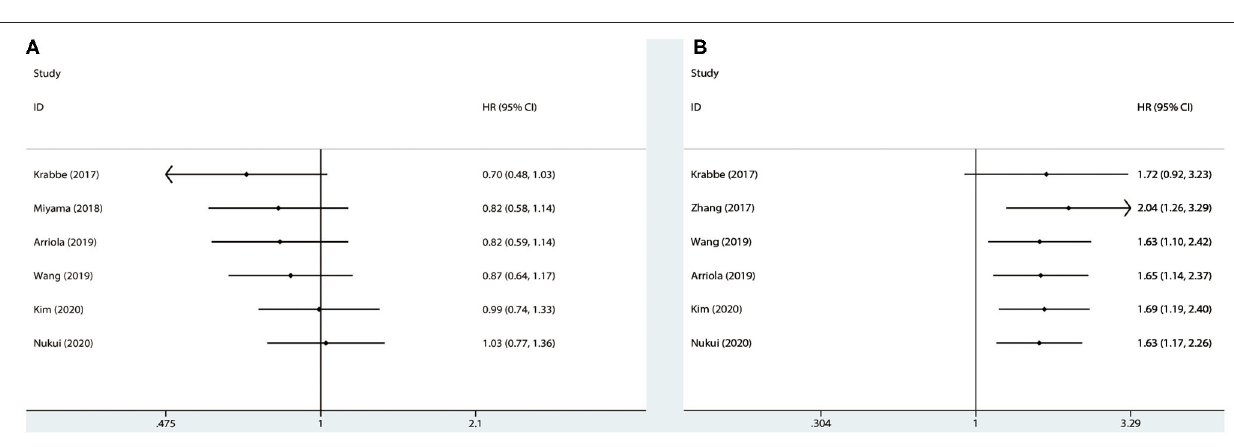
FIGURE 7 | Cumulative meta-analysis for OS (A) and CSS (B) , based on year of publication. OS, overall survival; CSS, cancer-specific survival; HR, hazard ratio; CI, confidence interval.